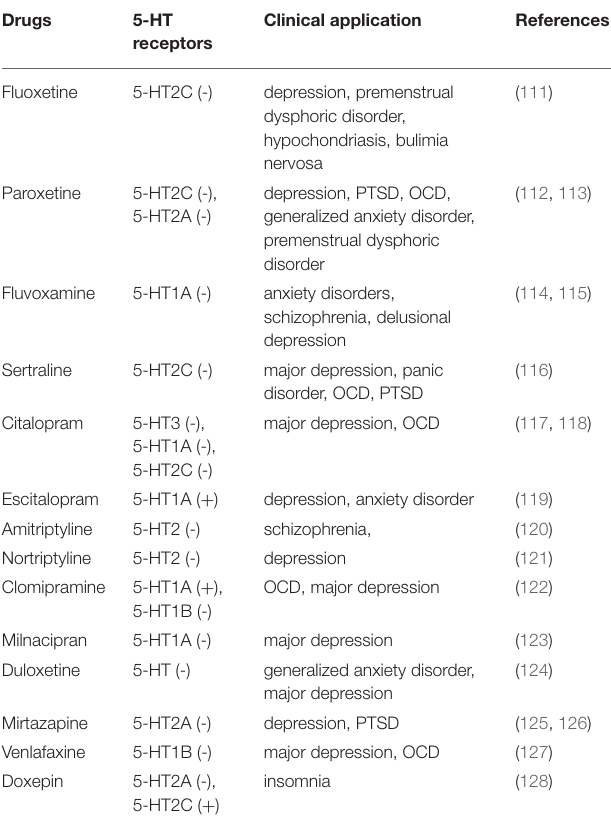
TABLE 2 | Main 5-HT drugs and their receptors for